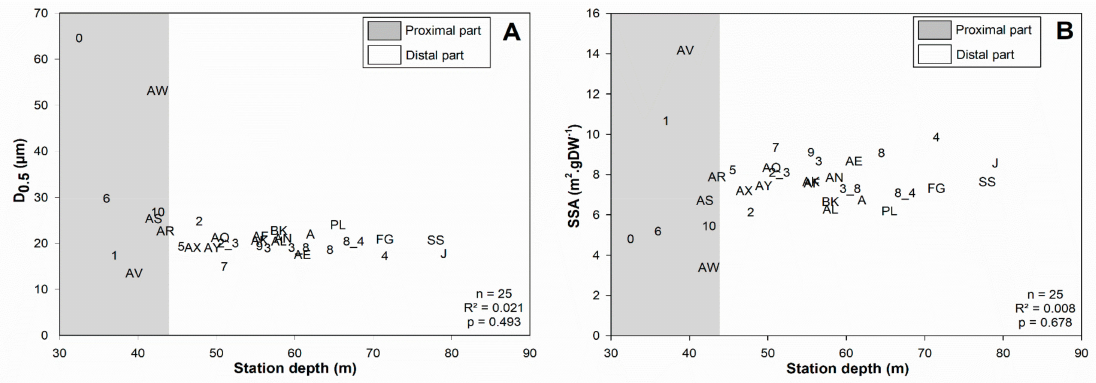
Figure 2. Relationships between station depth and: D 0.5 ( A ); Sediment Surface Area (SSA; ( B )). Gray areas represent the proximal part (z < 42.5 m) of the WGMP. Station codes are the same as in Figure 1 and Table A1. Statistical results refer to the sole WGMP distal